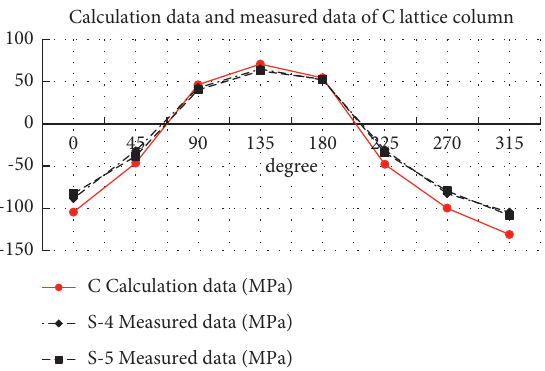
Figure 15: Comparison chart of calculated stress and measured stress of C lattice column.